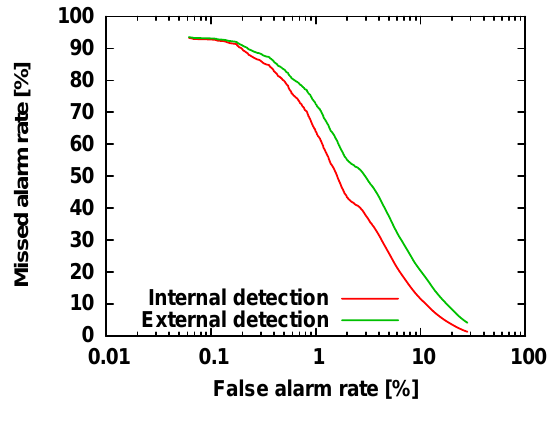
Figure 4. Comparison of ROC curves for detection of internal masqueraders and external masqueraders. The curves are the same as those in Figure 3. The horizontal axis is a logarithmic scale, so we can focus on the missed alarm rate at the low false alarm